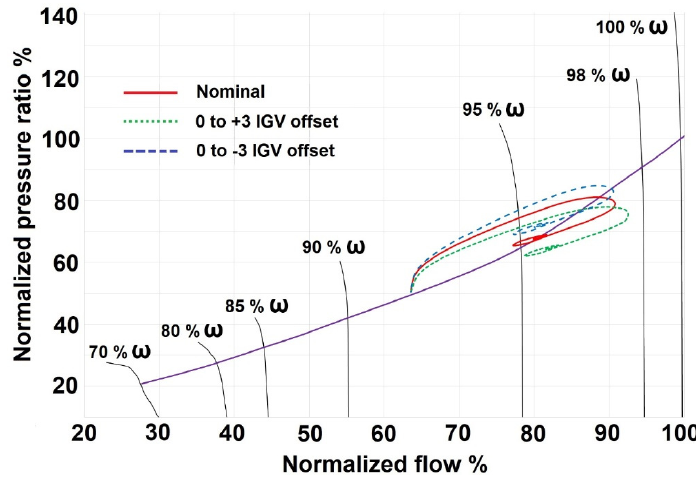
Figure 16. Simulated compressor dynamic response for 26–53% load and considering positive and negative IGV offset of 3 degrees at 53% load.